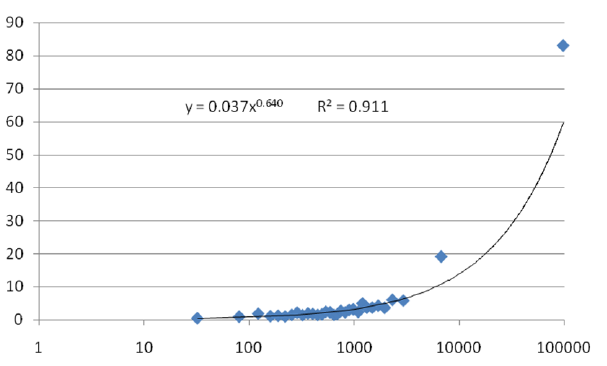
Fig. 2. Correlation between the index of technical urban facilities (vertical axis) and settlements population (horizontal axis, logarith- mic